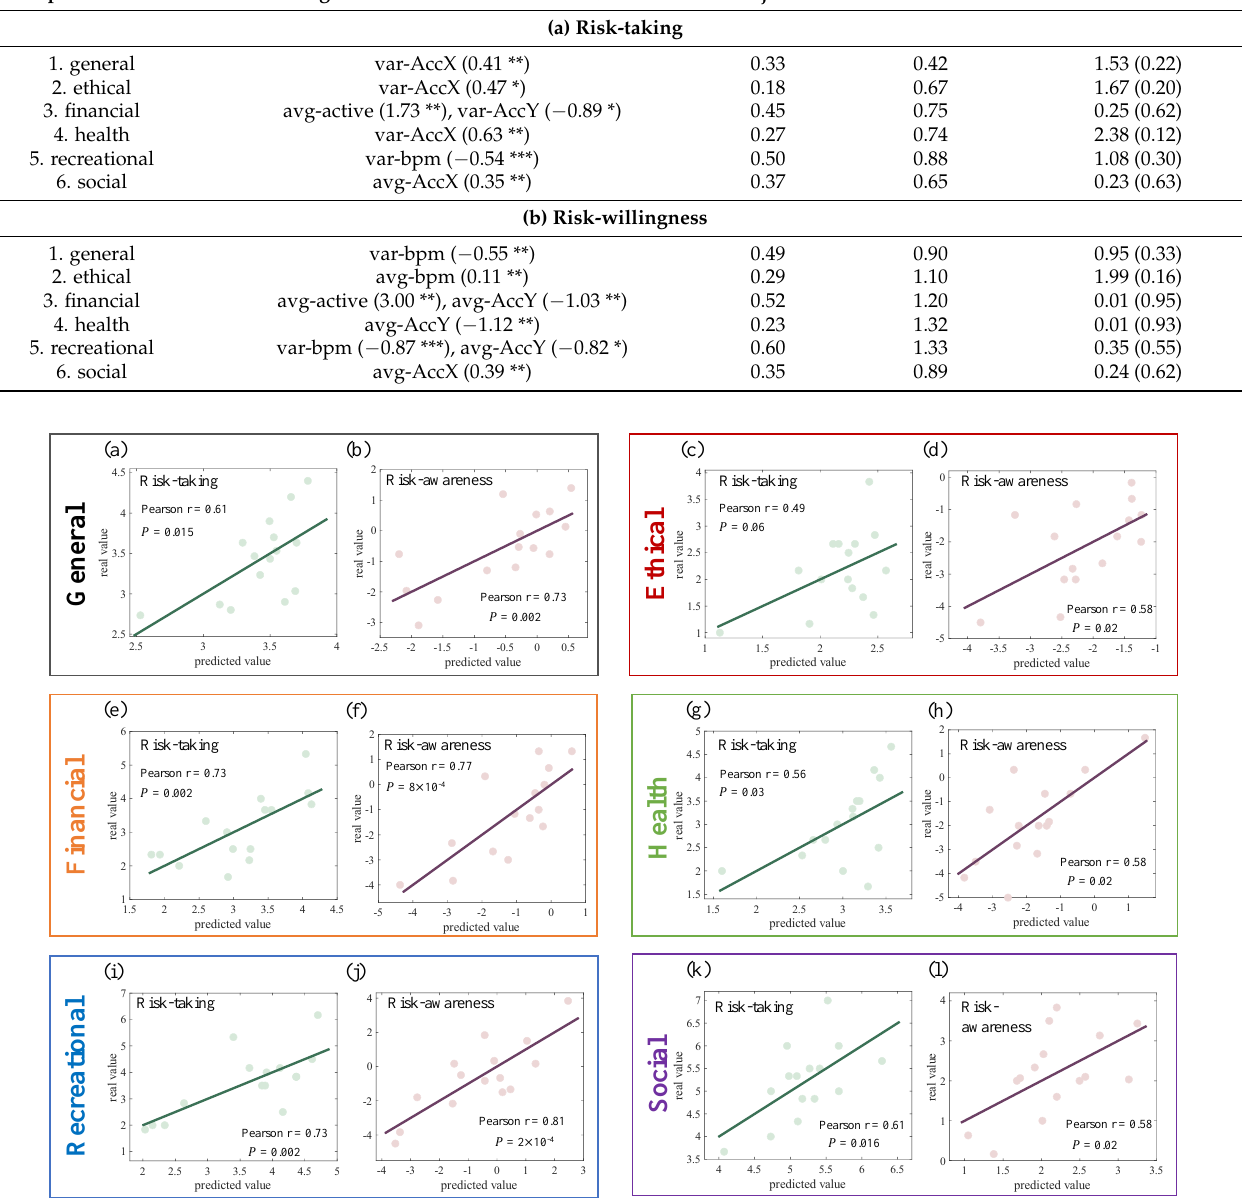
Table 4. OLS regression analysis of Study B based on 4339 sensor records and 2450 affective records from 15 participants. The stars within the bracket correspond to the predictor’s significance level: * p < 0.1, ** p < 0.05, *** p < 0.01. Dependent Var. Significant Predictor (Coefficient) Adj. R 2 RMSE Chi-2 (Prob. > Chi-2)